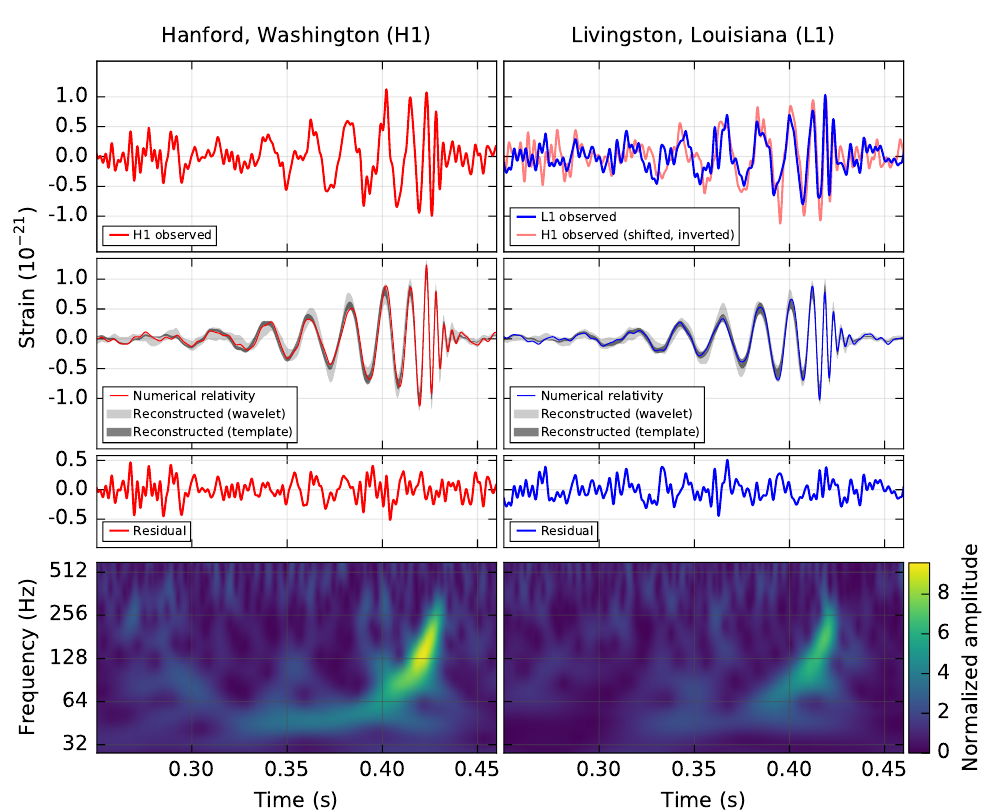
Figure 1. Strain data for the gravitational-wave event GW150914, produced by the collision of two black holes, and observed by the LIGO Hanford and LIGO Livingston detectors. The top row shows the band-passed strain output of the two detectors. In the right panel the LIGO Hanford signal is superimposed to the LIGO Livingston signal, with a time shift, to show the agreement between the two waveforms. The second row shows the comparison between the numerical relativity model of the event and the reconstructed signals. The residual difference between model and measurement in the third row shows the good agreement between theory and experiment. Finally, the bottom row shows time-frequency representations of the signals, where the characteristic chirp waveform is evident. Graphics reproduced from [2] under Creative Commons